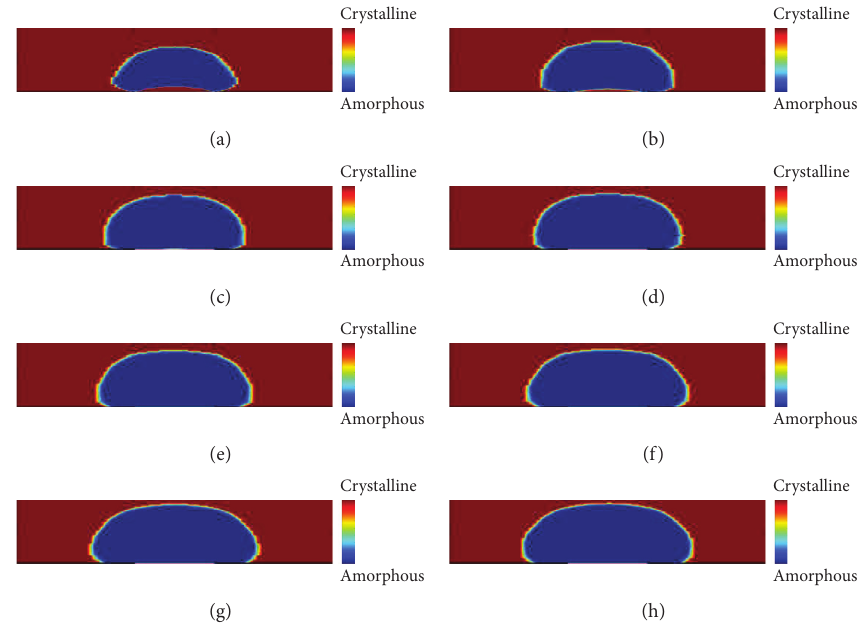
Figure 11: Phase distribution of simulation 3. (a–h) The phase distribution of GST after imposing 2 ∼ 9 (subsequently increasing by one) continuous pulses on the resistance change unit, respectively.